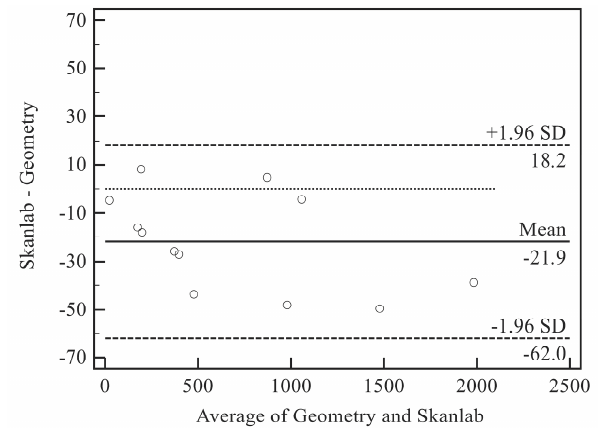
Figure 3. Bias and limits of agreement between SkanLab and Geometry for inanimate objects. SD, standard deviation.